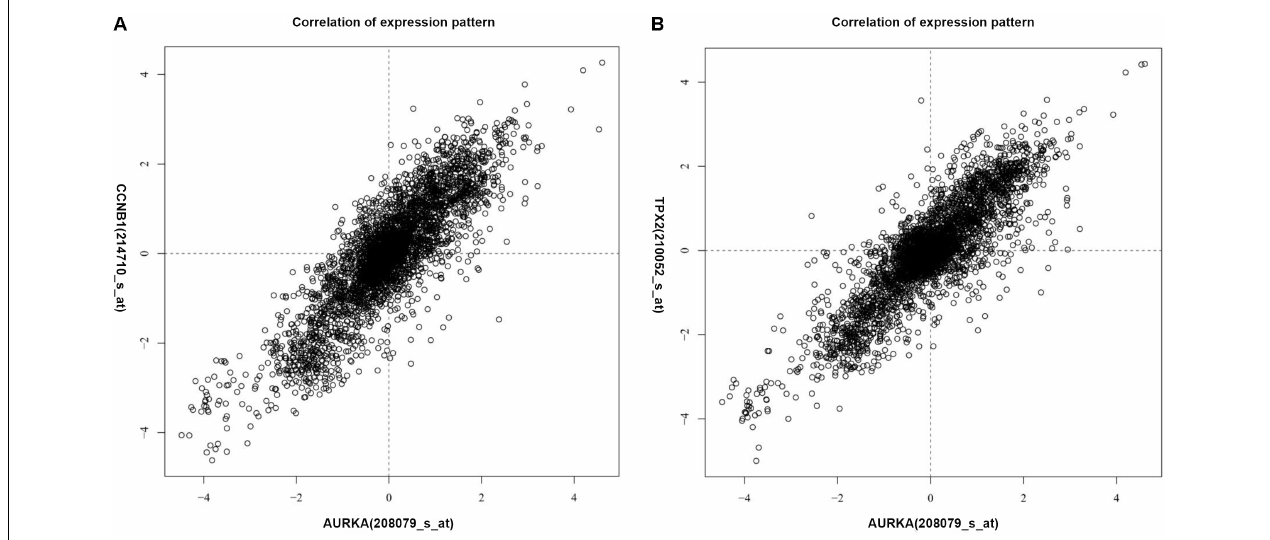
FIGURE 3 | Scatter plots for the mean expression across the AURKA gene and co-expressed gene. (A) CCNB1; (B) TPX2.